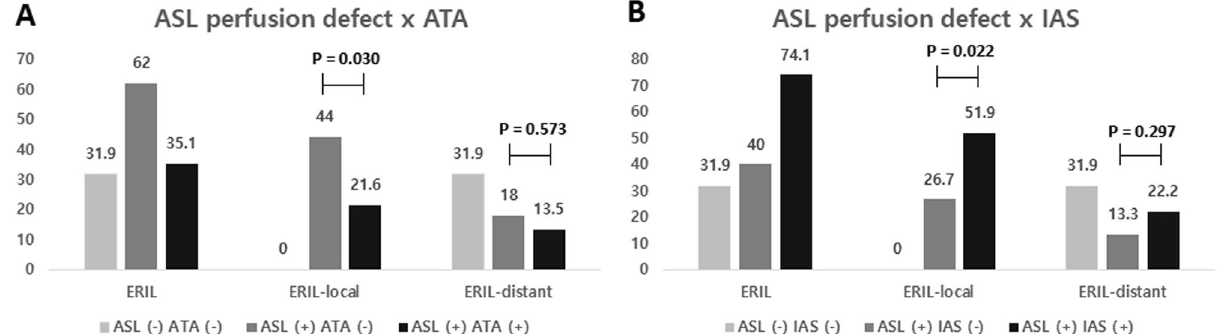
Figure 1. Effects of ATA and IAS on ERIL occurrence and locations. ATA arterial transit artifact, IAS intraarterial high-intensity signal, ERIL early recurrent ischemic lesion. ( A) When accompanied by ATA, the incidence of ERIL-local was significantly lower in patients with ASL perfusion deficits ( P = 0.030). However, in the case of ERIL-distant, the influence of ATA was unclear ( P = 0.573). ( B) Conversely, IAS significantly increased the incidence of ERIL-local in patients with ASL perfusion deficits ( P = 0.022). Likewise, the impact of IAS on the occurrence of ERIL-distant was also less pronounced ( P = 0.297).